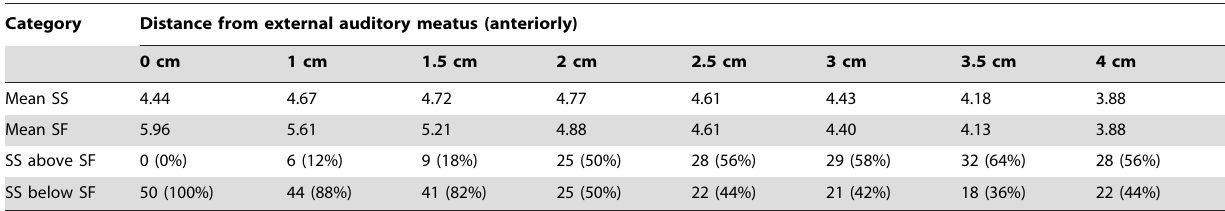
Table 3. Mean value of length of Squamous suture and Sylvian fissure in 50 patients (Left).